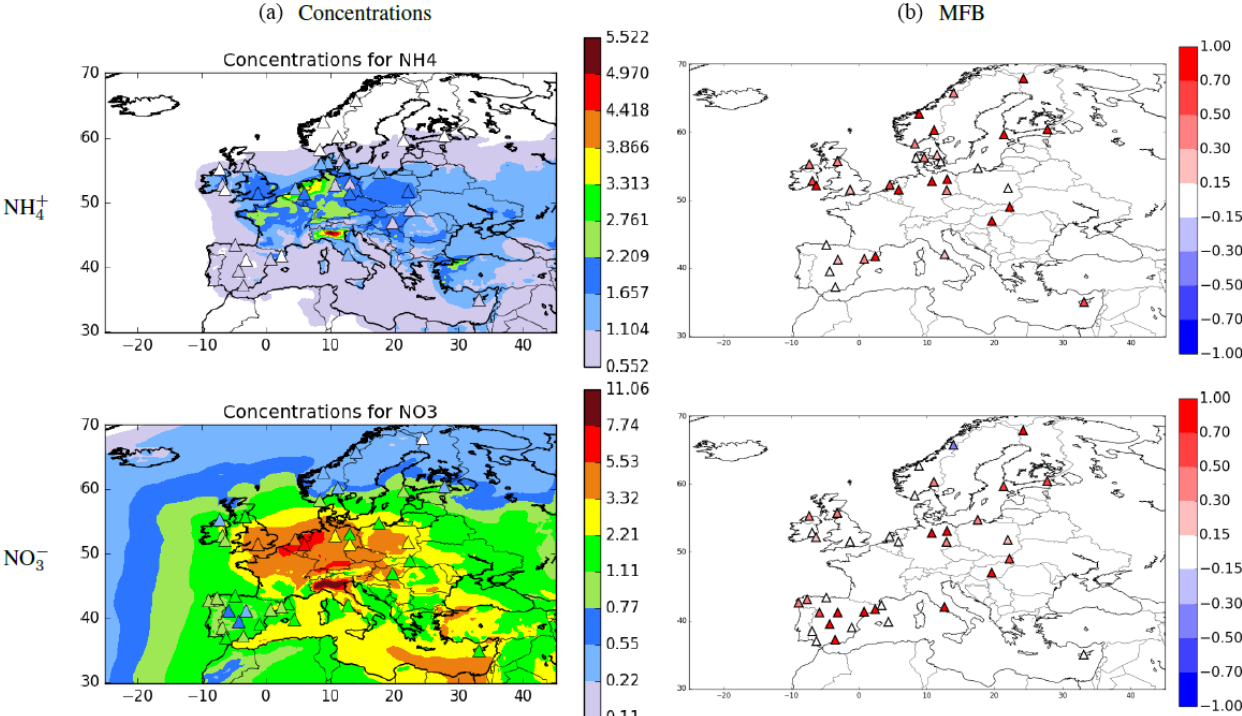
Figure 4. Modeled concentrations (in µgm − 3 ) and MFB for NH + panel (a) and to the MFB value in panel (b)